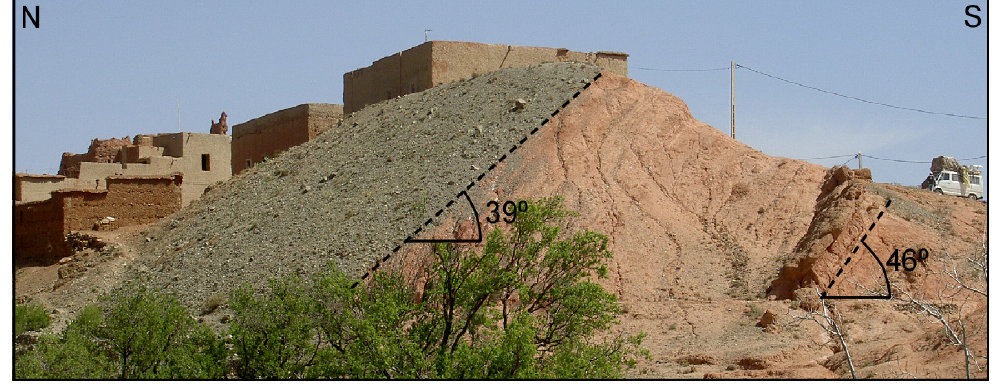
Figure 8. Example of a strongly warped Quaternary deposit (probably Q2), which is almost paraconformant with the Miocene bedrock, at the north- verging flexure 'c' in the Tanjout area. The field of view is 20 m. See location in Figure 2 and 3.